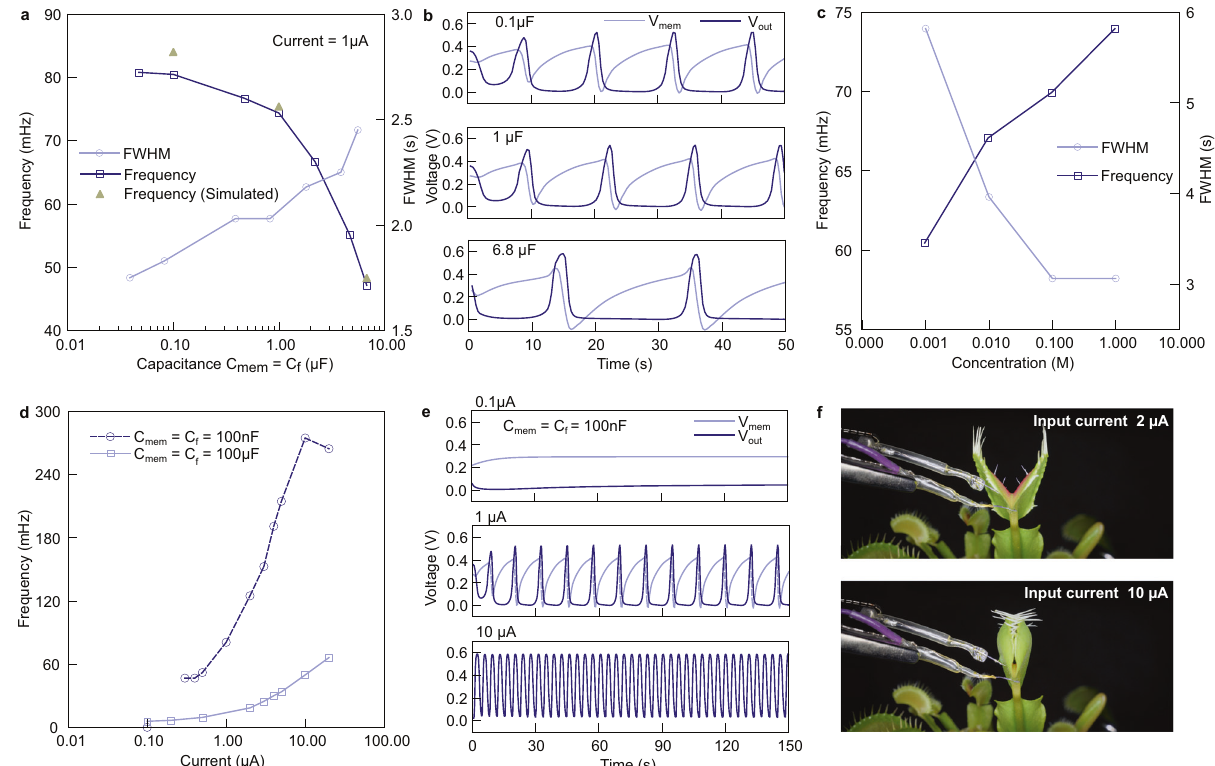
Fig. 2 Electrical characterization and bio-integration of the organic electrochemical neurons. a Modulation of frequency and FWHM of spikes with changing C mem and C f at a constant input current of 1 μ A. The 5% deviation in frequency between experimental and simulated values at low capacitances is due to the intrinsic capacitances dominating C mem and C f . b Changes of the spiking patterns at 3 different capacitances (0.1, 1, and 6.8 μ F). c Modulation of spiking frequency and FWHM with various NaCl concentrations. d Frequency modulation of neuron with the input current for two different capacitance con fi gurations. e Spiking patterns at three different input currents (0.1, 1, and 10 μ A) with C mem = C f = 100 nF. f Modulation of Venus fl ytrap using the arti fi cial neuron: the fl ytrap does not close at a low (2 µ A) input current to the neuron but closes when the input current is 10 µ